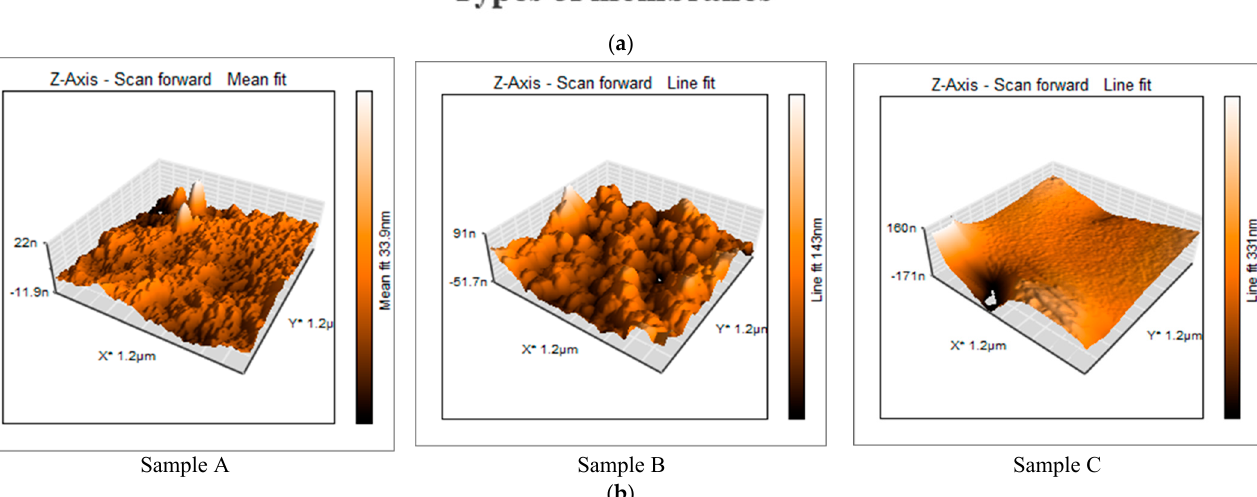
Figure 7. ( a ) Root mean square roughness from atomic force microscopy (AFM) for sample A, B, and C membranes. ( b ) AFM image analysis of different membranes.